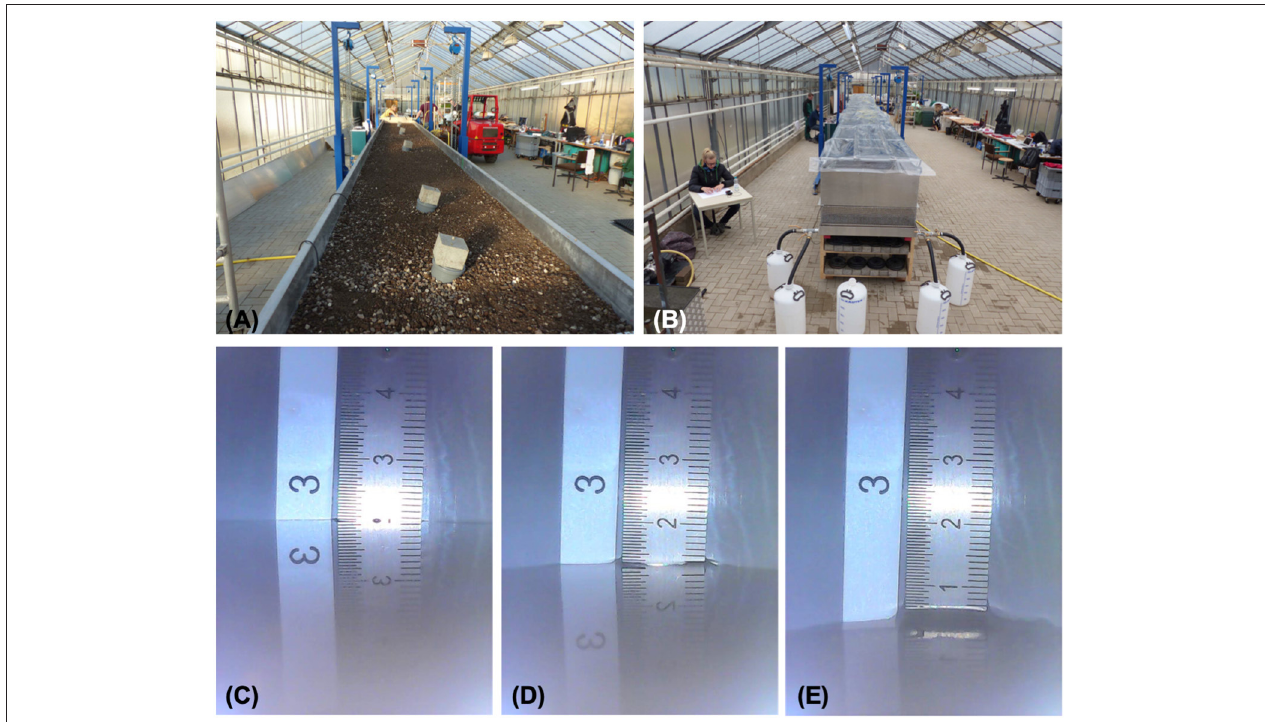
FIGURE 1 | (A) Built-in layer setup with camera measuring points. (B) Enclosed test facility during artificial rainfall experiments. (C–E) Water levels recorded with endoscope cameras.